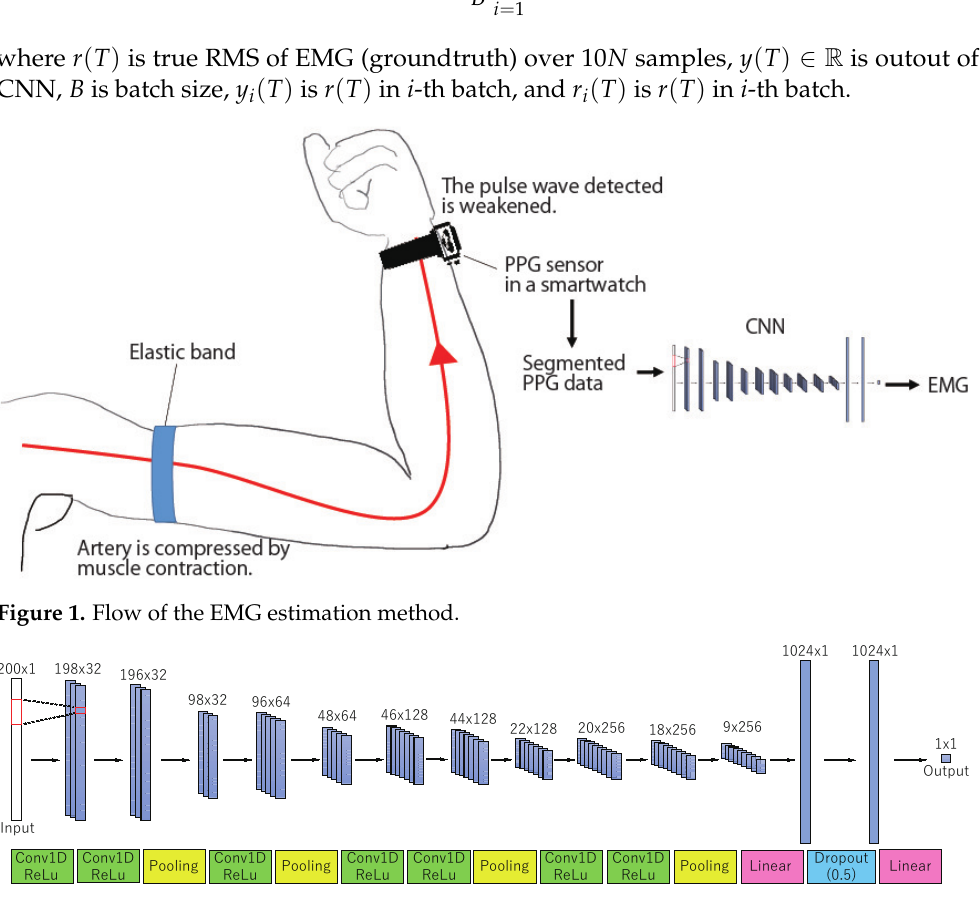
Figure 2. CNN for regression of RMS of